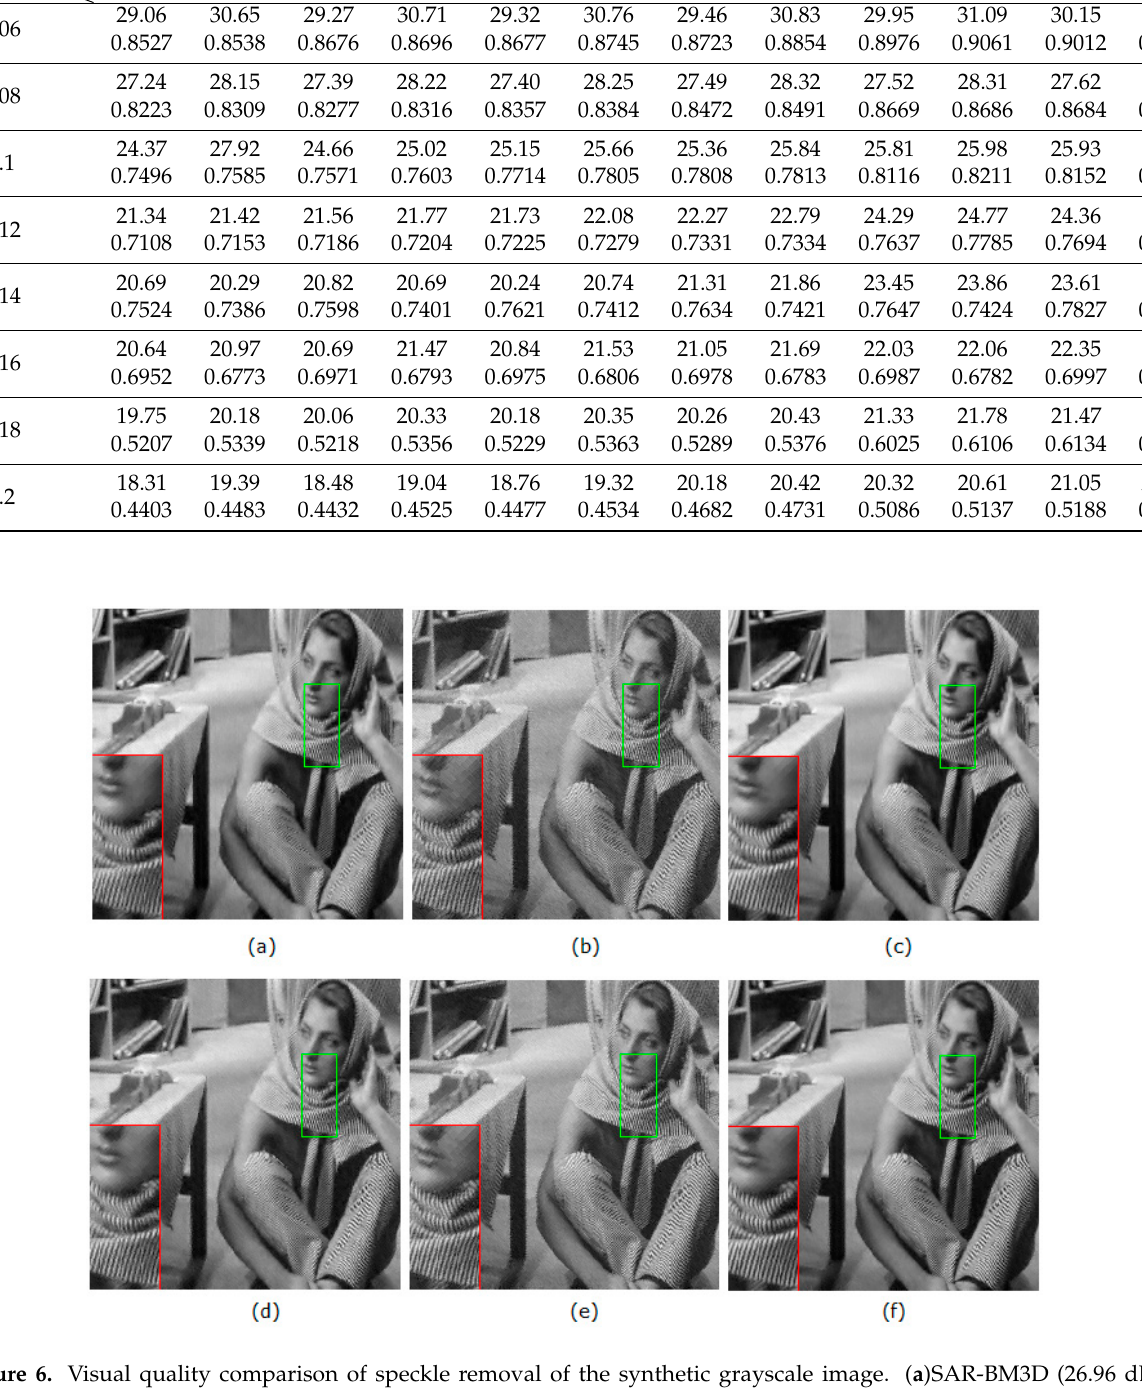
Figure 6. Visual quality comparison of speckle removal of the synthetic grayscale image. ( a )SAR-BM3D (26.96 dB); ( b ) SAR-CNN (27.28 dB); ( c ) ID-CNN (27.89 dB); ( d ) SAR-UNet (28.07 dB); ( e ) CCNN (28.32 dB); ( f ) CCNN+ (28.81